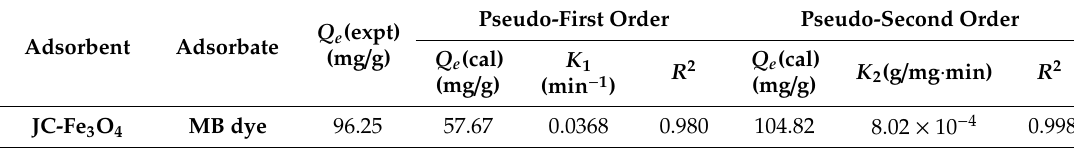
Table 2. Kinetics data with correlation coe ffi cients for MB dye onto JC-Fe 3 O 4. Q e (expt) Adsorbent Adsorbate (mg /